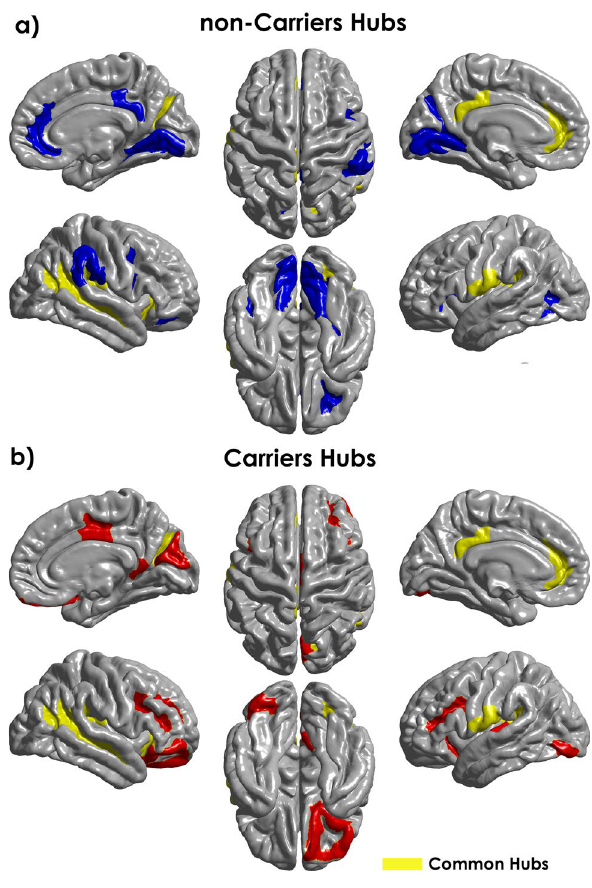
Figure 7. Hubs regions in MCI Carriers and non-Carriers based on the Normalized Betweenness Centrality (NBC). The blue regions represent hubs in the Carriers and the red ones the non-Carriers. In yellow are represent hubs common to both groups. The NBC values were mapped onto the cortical surfaces using the BrainNet Viewer package (http://www.nitrc .org/proje